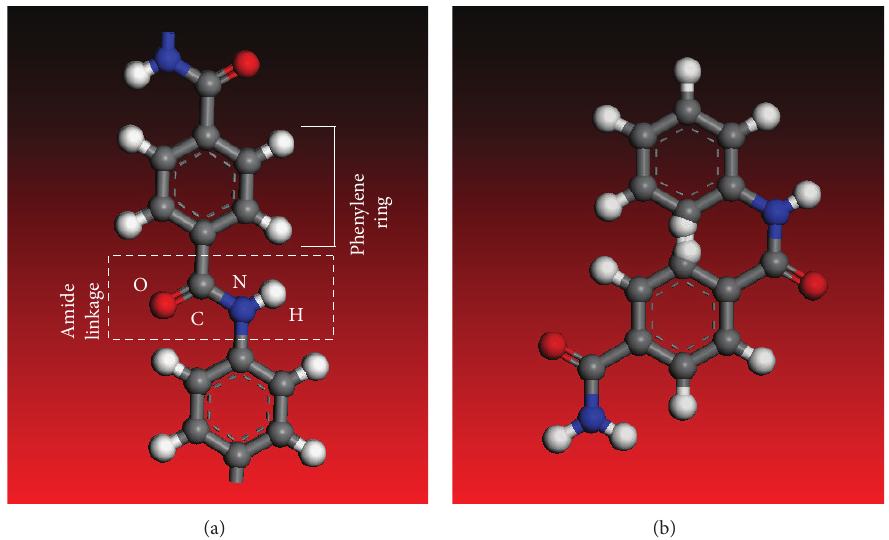
Figure 1: (a) Trans - and (b) cis -molecular conformations in typical PPTA-based polymeric-material chains/molecules.